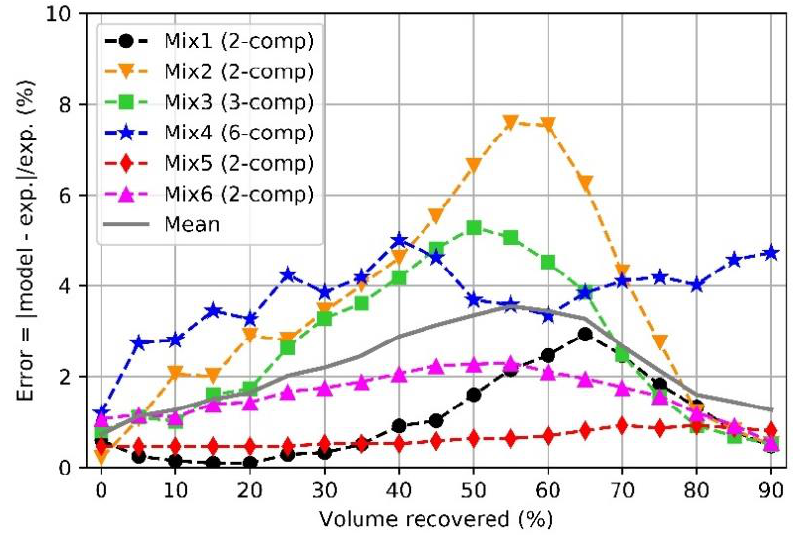
Figure 3. Absolute relative error in predicting the distillation kettle temperature for six validation mixture (marker-lines) from literature and their mean absolute relative error (solid line).